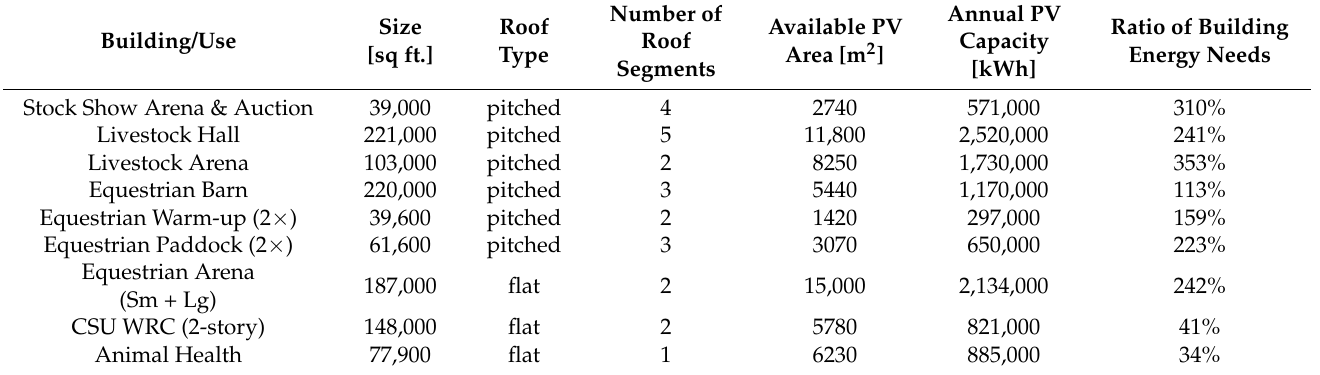
Figure A2. NWC campus distribution of building area and energy load. While representing only 12% of building area, the CSU WRC and Animal Health buildings comprise 27% of the energy load. Conversely, the Livestock and Equestrian complexes represent 45% of building area, but only 25% of energy load. The existing Stadium/Hall of Education complex is the largest single building energy load. Table A4. PV Production Estimation on a per roof segment basis for the various building complexes of the NWC. The high energy use intensity Water Resource Center (WRC) and Animal Health buildings are unable to generate sufficient PV energy to offset their own needs, while the large area and low energy use intensity Stock Show, Livestock, and Equestrian building generate a surplus of PV energy relative to their own individual energy use.